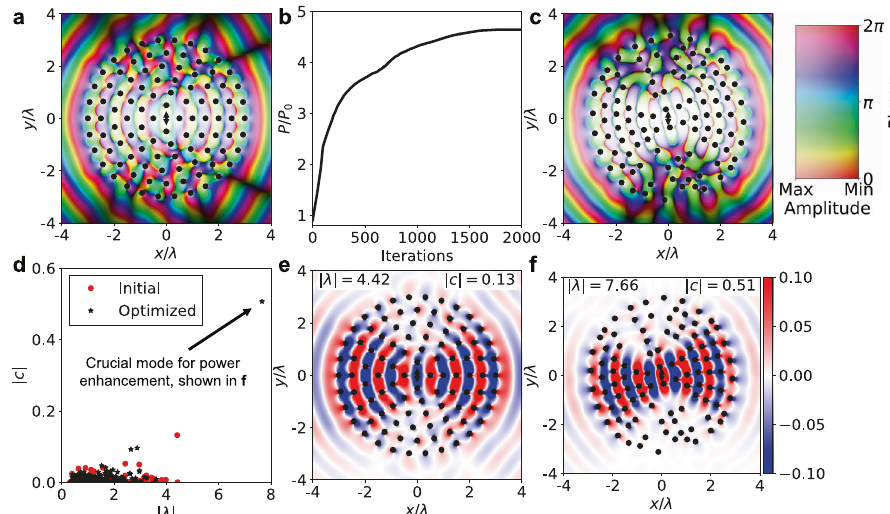
Fig. 3 The result of applying our design methodology to enhance power emission of a dipole using 100 scatterers. In all plots, scatterers are shown as black circles and the dipole emitter as a black arrow. ( a ) Shows the ^ y component of the electric fi eld in the initial con fi guration, ( b ) shows the progress of the power enhancement as the optimisation progresses and ( c ) shows E y in the optimised con fi guration. ( d ) shows how the eigenvalues and expansion coef fi cients change due to the optimisation. ( e ) and ( f ) show Re ½ E (cid:5) ^ y (cid:3) of the mode with the largest expansion coef fi cient in the initial and optimised structure respectively. The fi nal mode, plotted in ( f ), with eigenvalue ~8 and expansion coef fi cient ~0.5 is responsible for the power